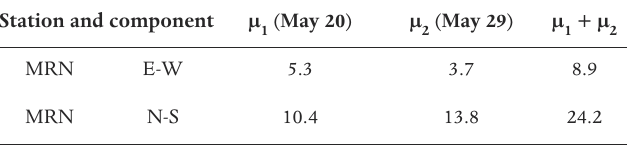
Table 2. Kinematic ductility demand for the MRN